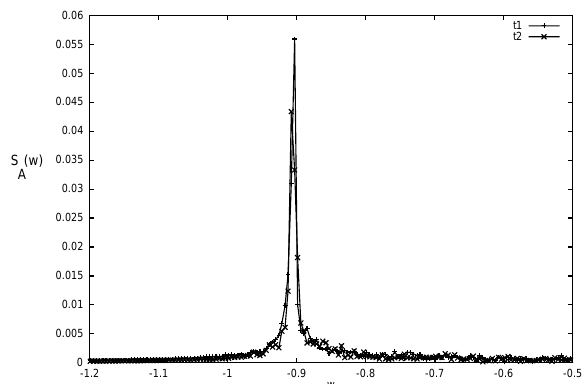
FIG. 6. Frequency spectrum of the centroid motion at two successive time intervals of 2 16 turns ( N (cid:1) 10 4 ), considering head-on collisions of two round bunches with current ratio r (cid:1) 0.6 and initial offset of d (cid:1) 0.2 (in units of s x ). The p mode at 2 0.9 is Landau damped. Solid line and plus symbols: first time interval; dashed line and crosses: second